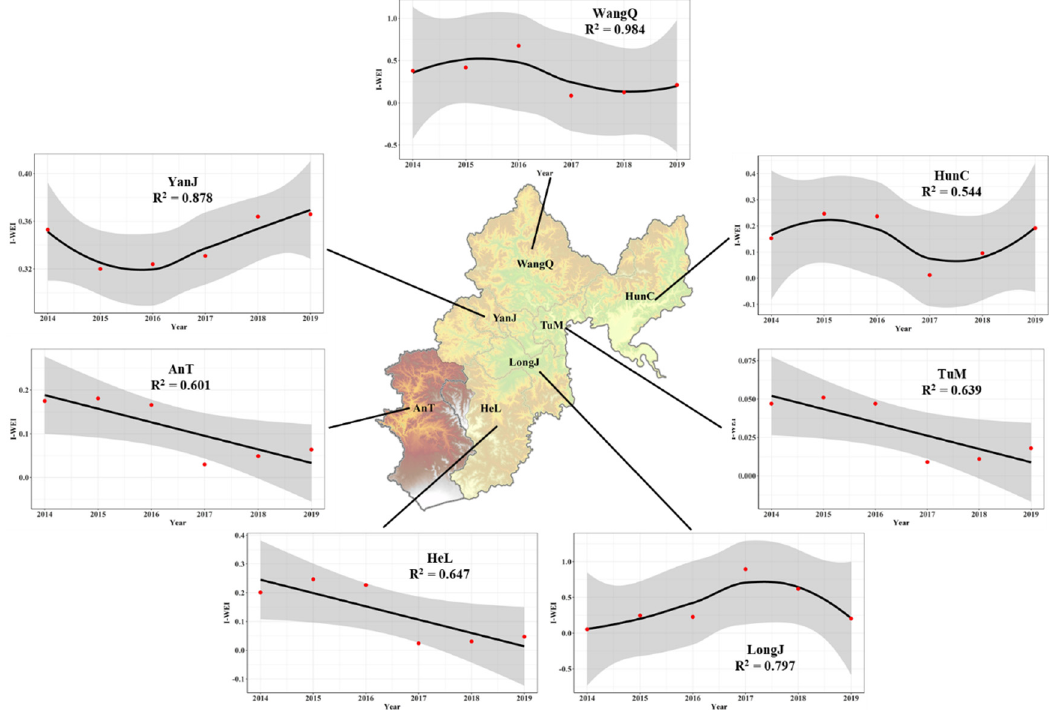
Figure 12. The trend of industrial water efficiency from 2014 to 2019.